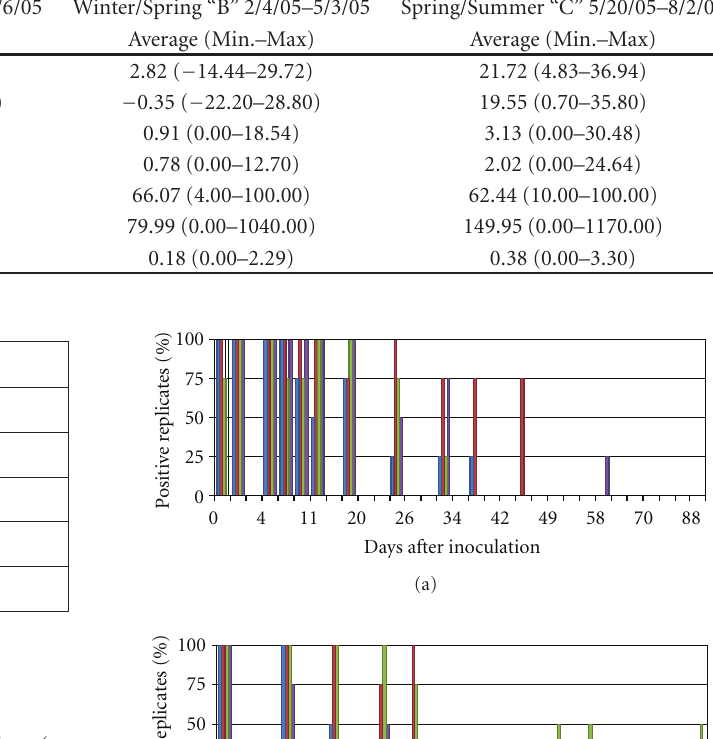
Figure 4: The overall mean and maximum survival time (per- sistence) of M. bovis in all substrates exposed to natural envi- ronmental conditions in Fall/Winter “A”, Winter/Spring “B”, and Spring/Summer “C”. Error bars represent standard deviation.